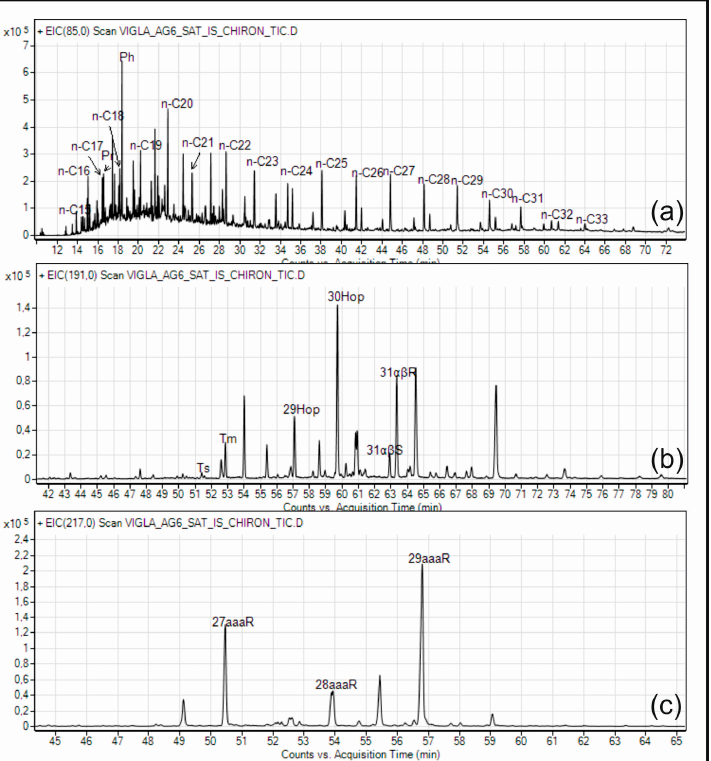
Figure 9. ( a ) N-alkanes (n-C), phytania (Ph), ( b ) Hopanes, and ( c ) Steranes for sample AG6. According to Table 7, diagrams were constructed showing the distributions of n-al- kane concentrations for each analyzed sample (Figure 10). Table 7. Geochemical indices for n-alkanes. Saturate Indices